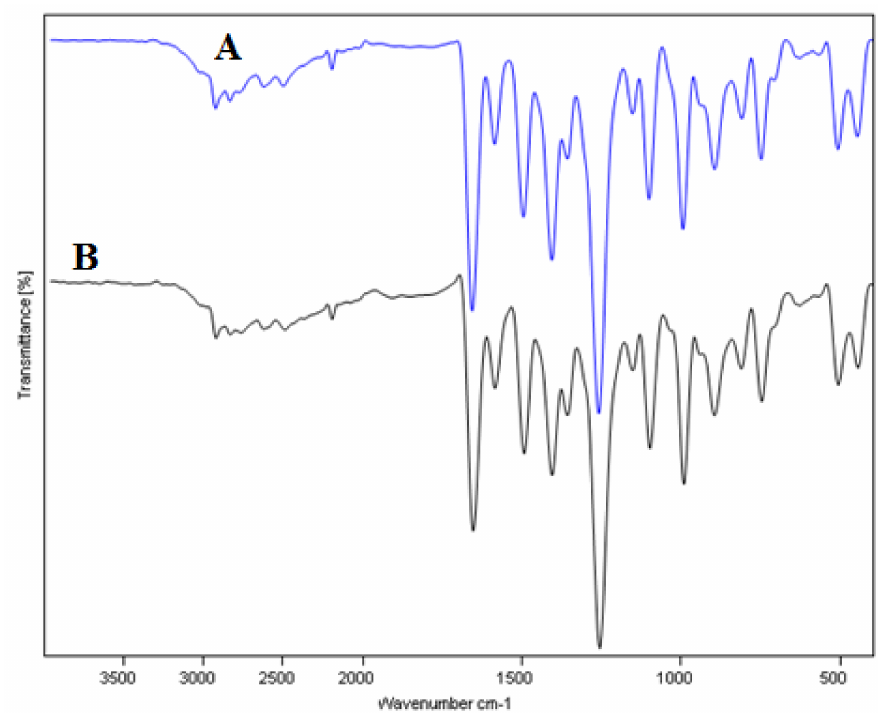
Figure 3. Fourier transforms infra-red (FTIR) spectra of ( A ) pure FBX and ( B ) equilibrated FBX recovered from water.